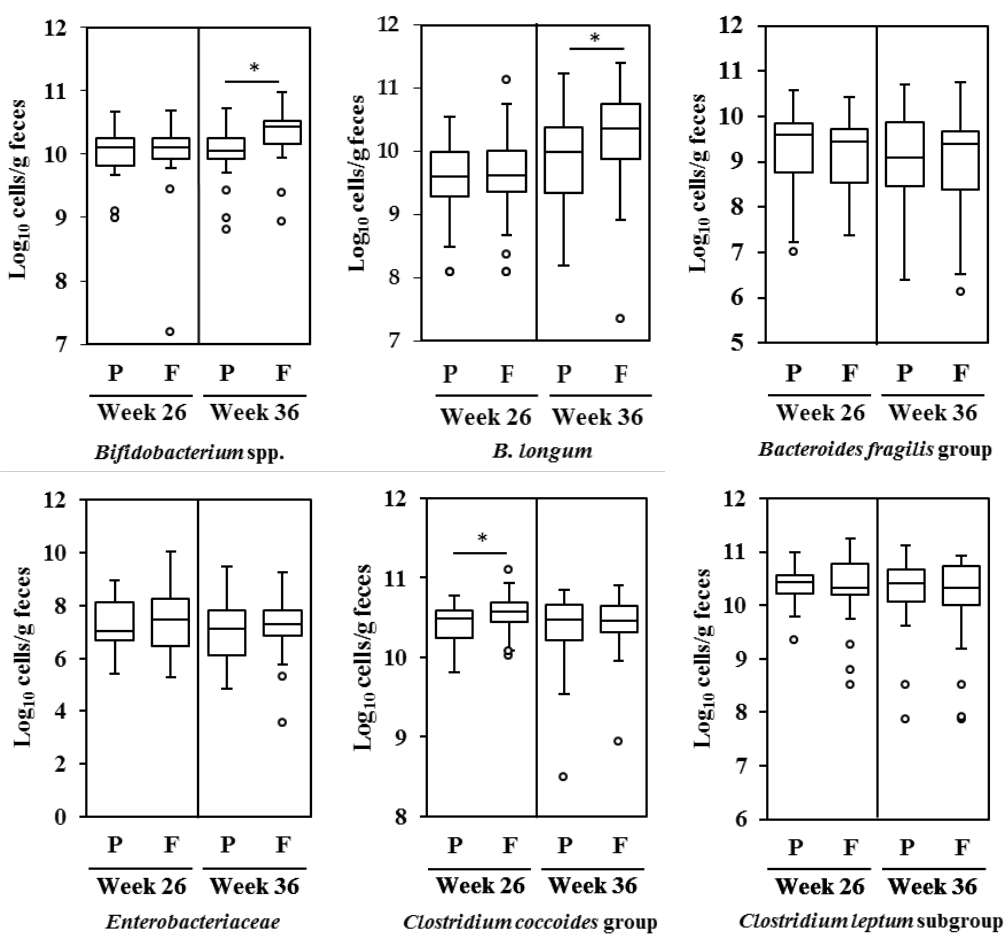
Figure 2. The number of gut microbiota, expressed as the logarithm of cell numbers, in maternal feces at 26 and 36 weeks of gestation. Microbiota were quantified using q-RT-PCR ( n = 29 and 34 for the placebo and FOS group, respectively). Box and whiskers plot, with the black horizontal line representing the median value and the boxes the interquartile ranges. The T-bars represent the data range, and the open circles indicate the presence of outliers (data points more than 1.5 interquartile ranges below the first quartile or above the third quartile). * Statistically different based on a Mann-Whitney U test ( p < 0.05). P: Placebo group; F: FOS group.